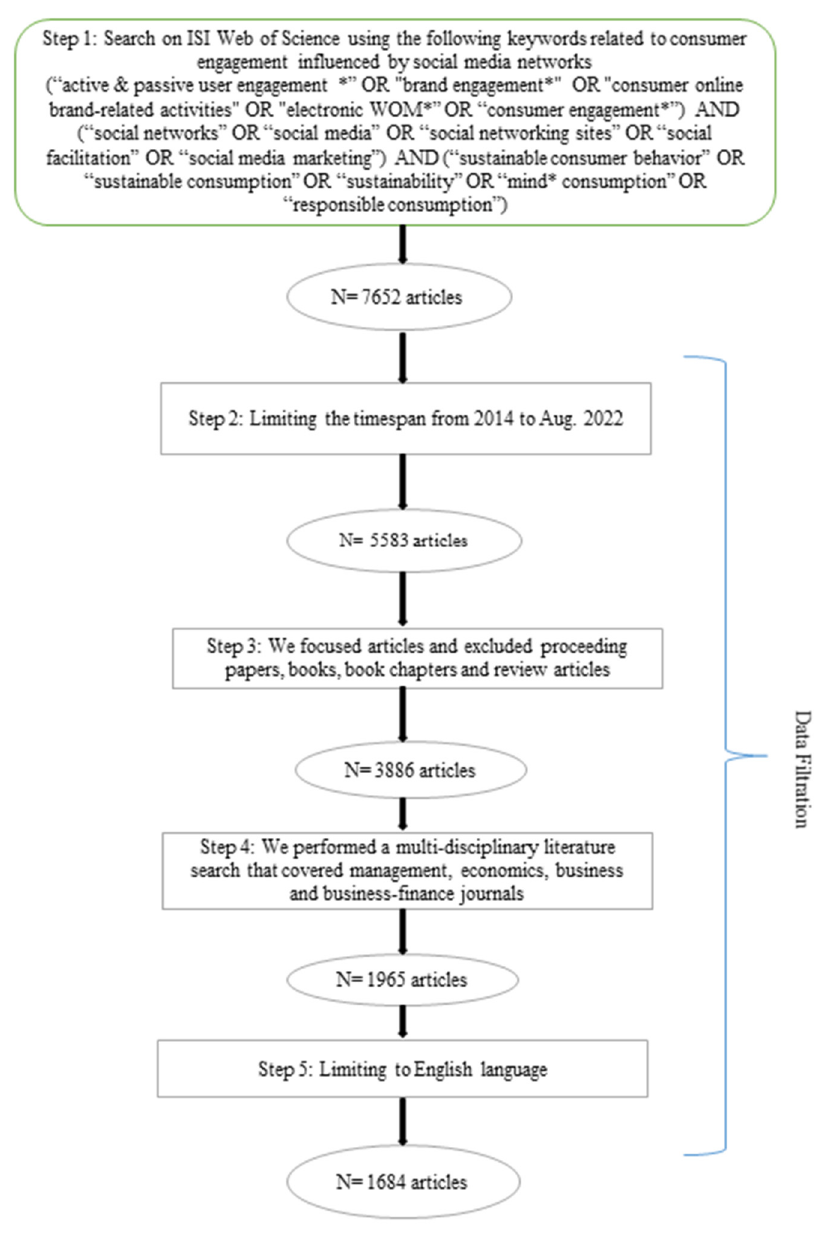
Figure 1. Identification of initial inclusion criteria for articles in this review. Note: * in the search string denotes that different word endings following this symbol are included in the search